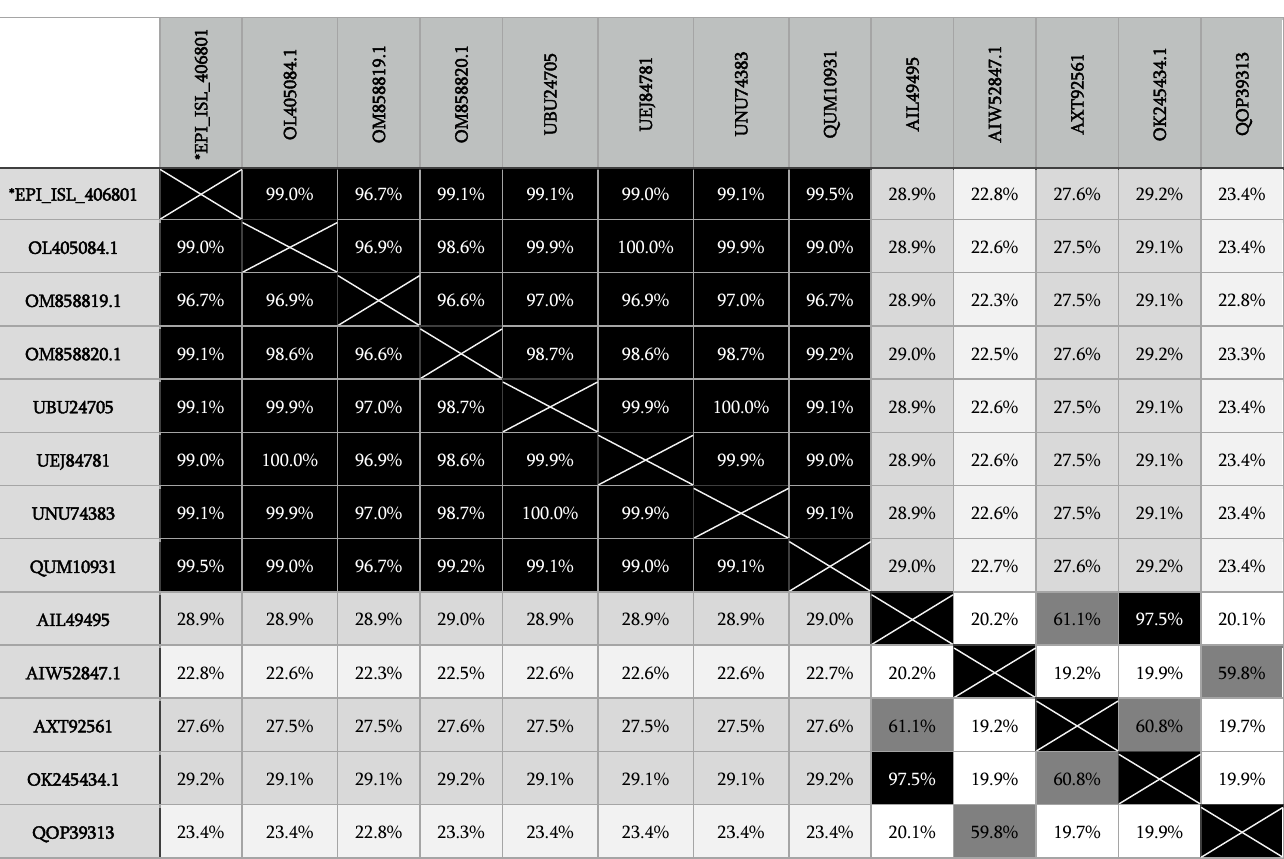
Table 1. Amino acid alignment of SARS-CoV-2, BetaCov/Wuhan/WH04/2020 and other human coronaviruses (OC43, NL63, HKU1, 229E) for similarity. *EPI-ISL406801: The S sequences of “Be- taCov/Wuhan/WH04/2020” were used in this study. OK245434.1: Human coronavirus